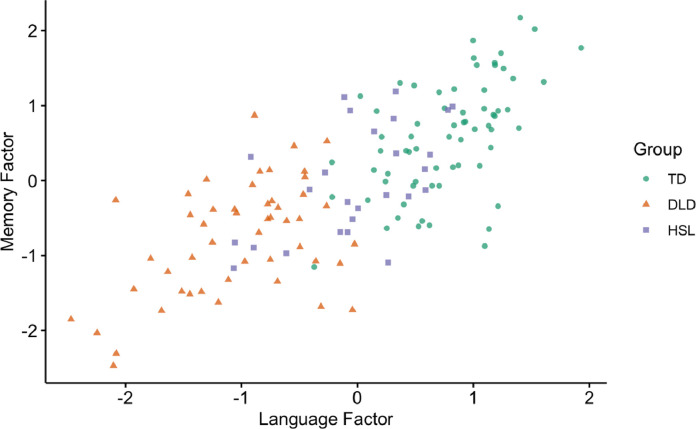
The relationship between language and memory proficiency scores in our sample is illustrated here. Language factor scores are plotted on the X axis, and memory factor scores are plotted on the Y axis. Colour and shape depicts group membership (TD – green circles, DLD – orange triangles, HSL – purple squares).